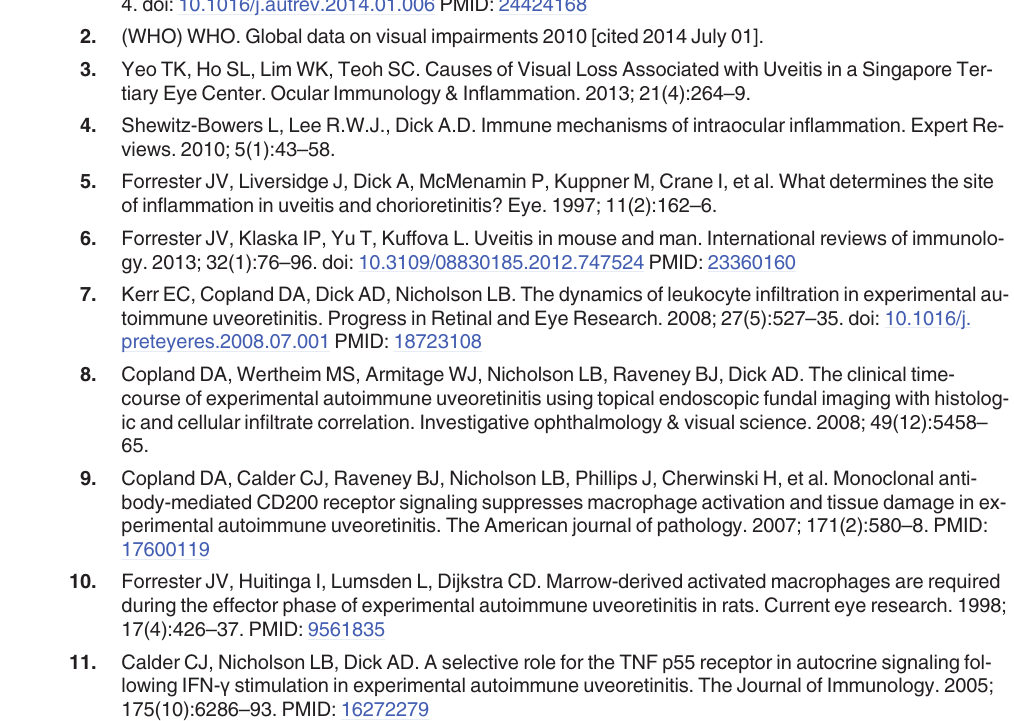
S5 Fig. Daily treatment with 20mg/kg or 35mg/kg SB-435495 did not significantly reduce the number of cells infiltrating the retina. A) Percent inhibition calculated from murine plas- ma, taken at time of sacrifice (n = 3) B) Quantification of cells infiltrating the retina at day 14 and 21 post immunisation (n = 3) (cid:1)(cid:1) p < 0.01 (TIF) S6 Fig. Twice daily treatment with 30mg/kg SB-435495 significantly reduced Lp-PLA tivity in murine plasma. A) % Lp-PLA from murine plasma, taken at time of sacrifice (n = 14 – 15). (cid:1)(cid:1)(cid:1) p < 0.005 (cid:1)(cid:1)(cid:1)(cid:1) p < 0.001